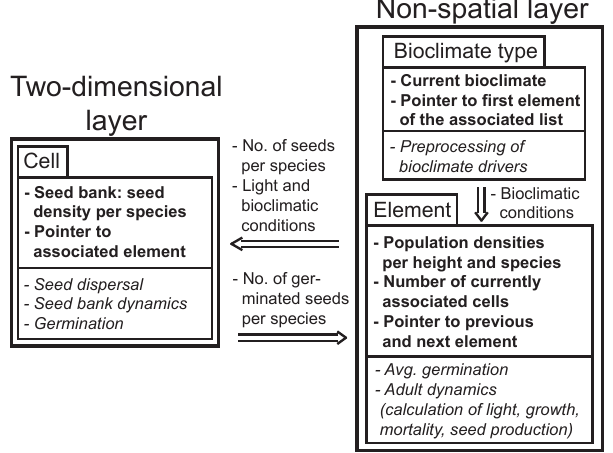
Figure 2. Outline of the architecture of TreeMig-2L. The two- dimensional layer consists of single cells whose state variables are seed densities per species in the seed bank. Additionally, each cell has a pointer – a data type allowing for direct access – to the ele- ment on the non-spatial layer with which the cell is currently asso- ciated. The non-spatial layer consists of bioclimate types and linked lists of associated elements (for more information see Supplement Sect. S1.1). State variables are printed in bold, processes in italic type. Items listed on the arrows represent information exchanged between the layers and between bioclimate types and elements of their associated